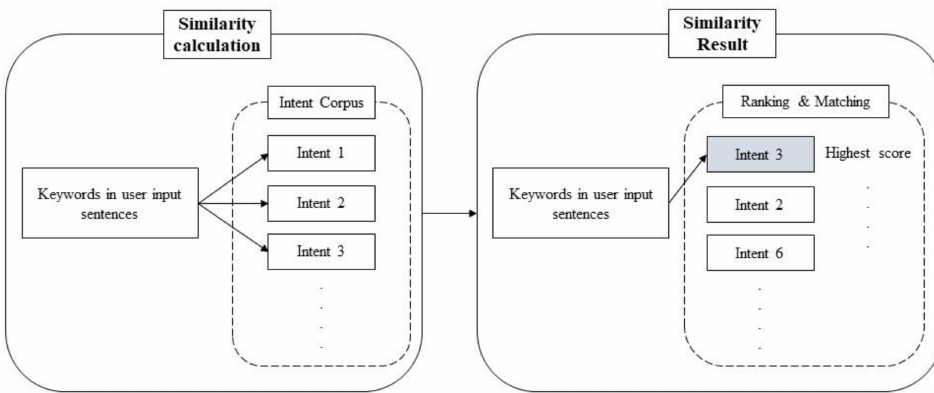
Figure 5. Schematic diagram of the ranking and matching process.